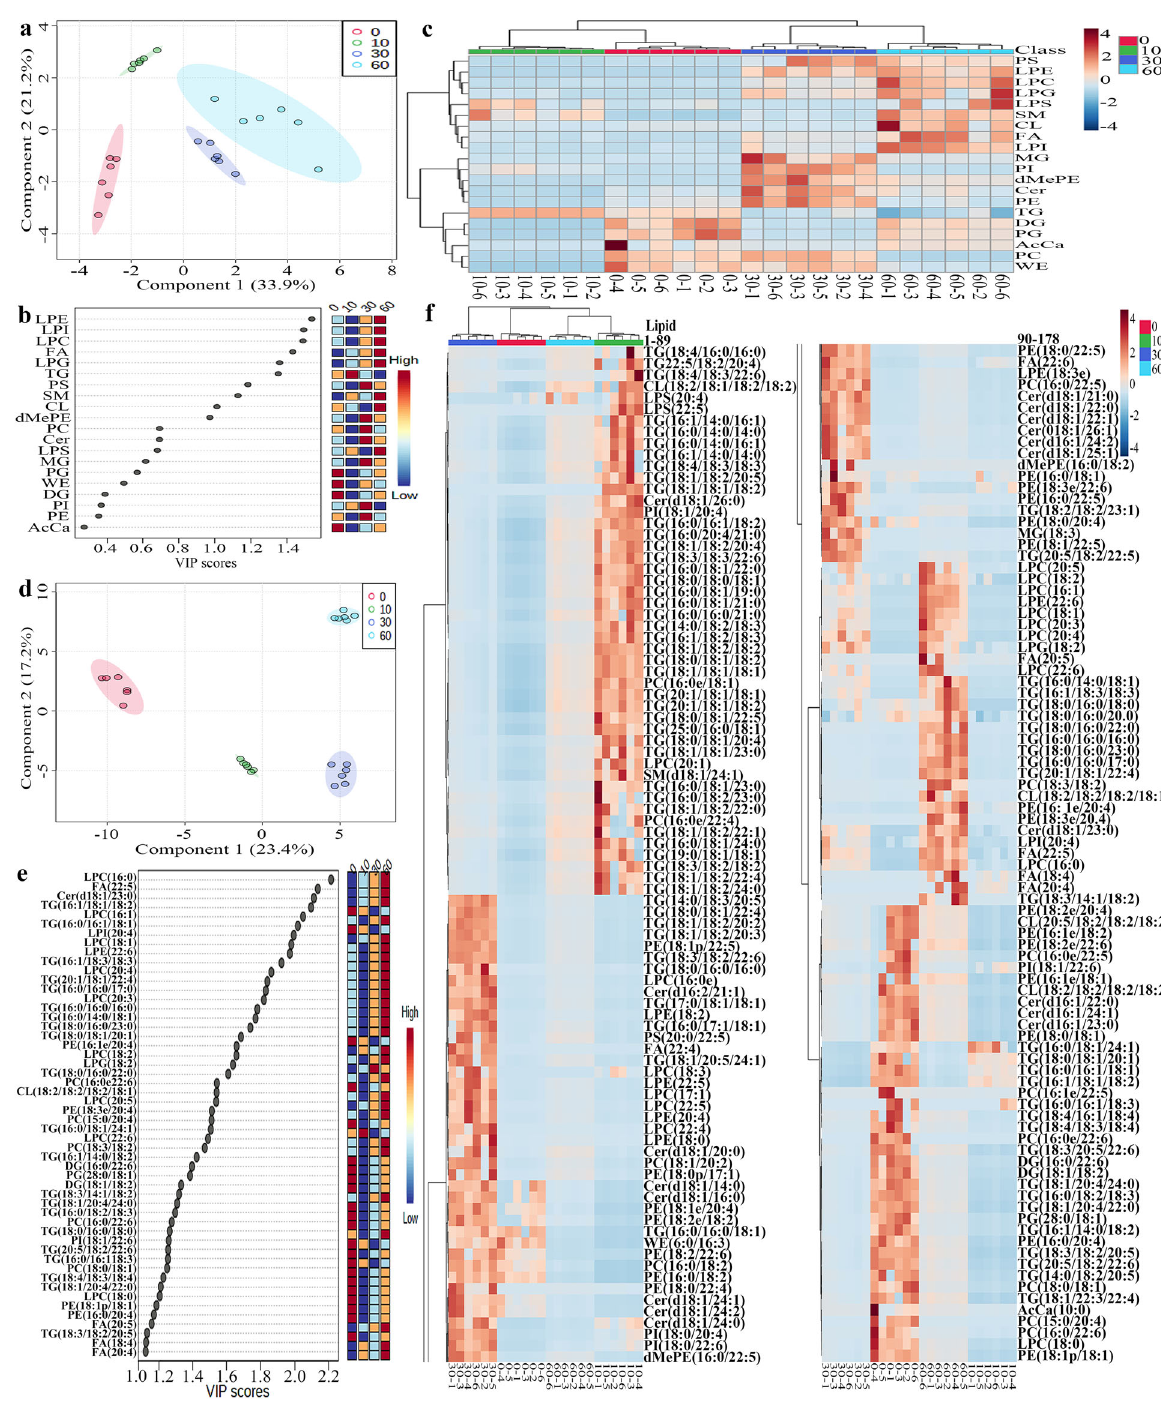
Fig. 2 Statistical analyses of lipids in tilapia muscle at different steaming times by Metaboanalyst 5.0 online software according to the normalized MS data. a PLS-DA score plot of lipid classes. b Variable importance in projection (VIP) scores of lipid classes in PLS-DA. c Heat map of lipid classes. d PLS-DA score plot of individual lipids. e VIP scores of individual lipids in PLS-DA. f Heat map of individual lipids. The colored boxes on the right of VIP score images indicate the relative peak area of the corresponding lipid classes. Each colored cell in the heat map corresponds to a peak area value of the lipid classes or individual lipid on the right side. In the colored cells, red color is high and blue color is